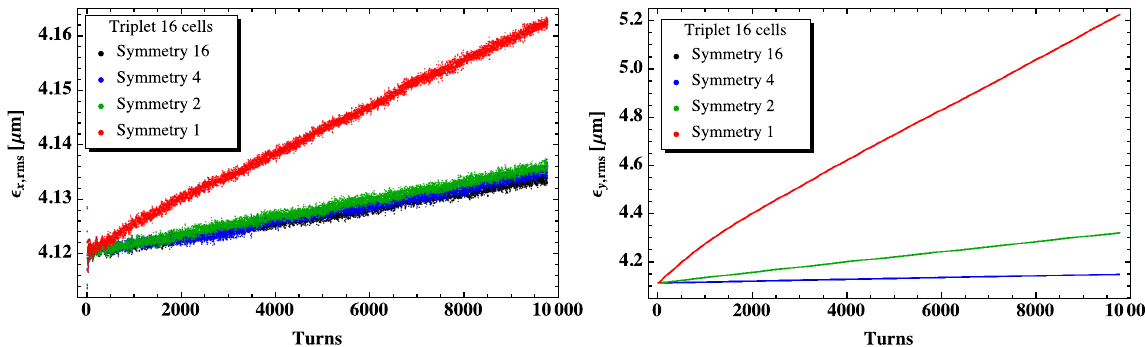
FIG. 9. Time evolution of horizontal (left) and vertical (right) rms emittance for the 16-cell triplet lattice with onefold, twofold, fourfold and 16-fold